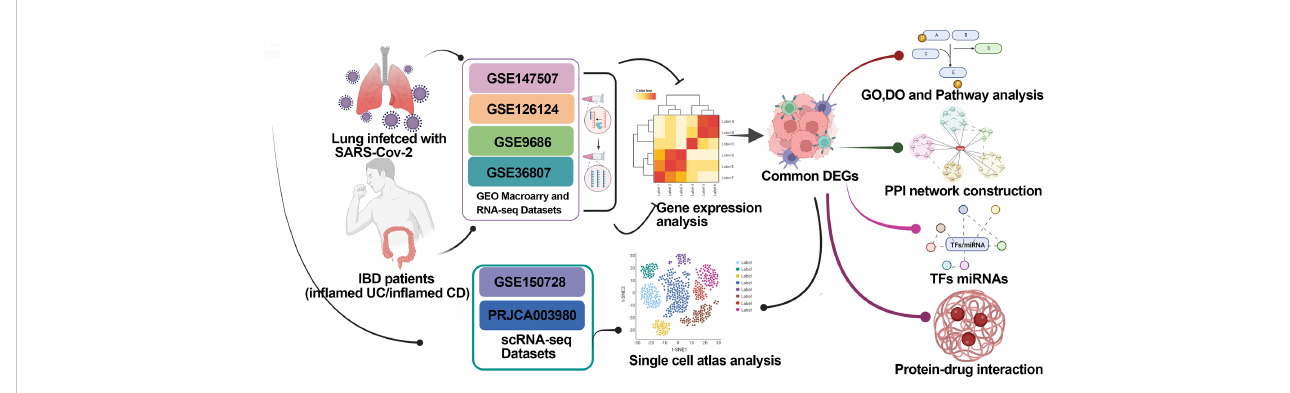
FIGURE 1 Schematic diagram of the whole work fl ow of this